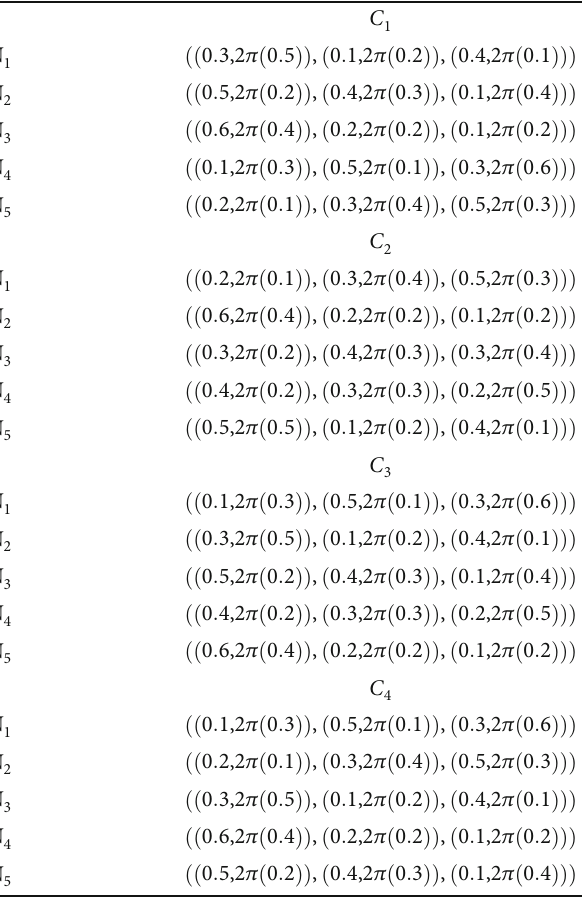
Table 2: Preferences for alternatives provided by expert E ð 2 Þ . C 1